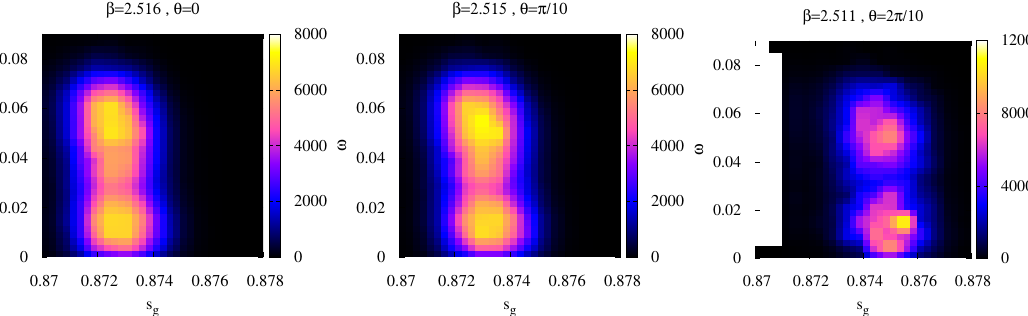
Figure 7 . Some examples of the denominator of the integrand in (2.12) for θ = 0 , π/ 10 and 2 π/ 10 from left to right. In the plot for θ = 2 π/ 10 , the results below s g ∼ 0 . 872 are not shown because of too large statistical uncertainties.